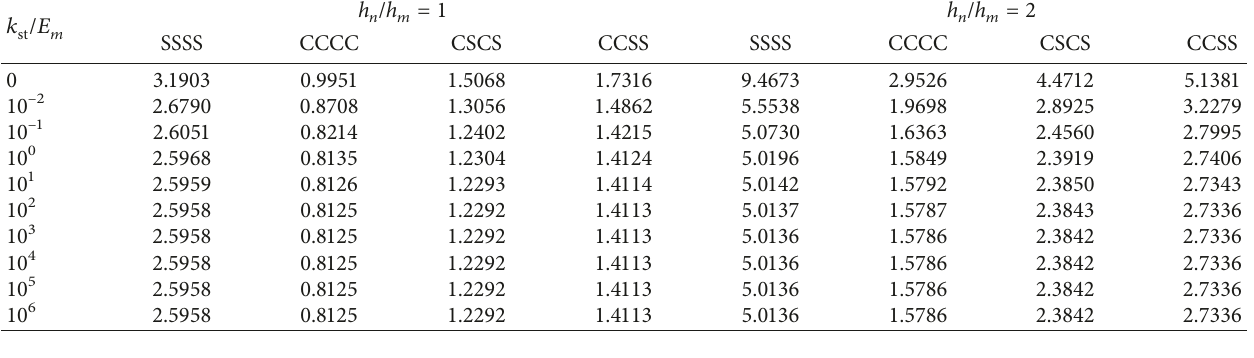
/ E m with a/b � 1. st